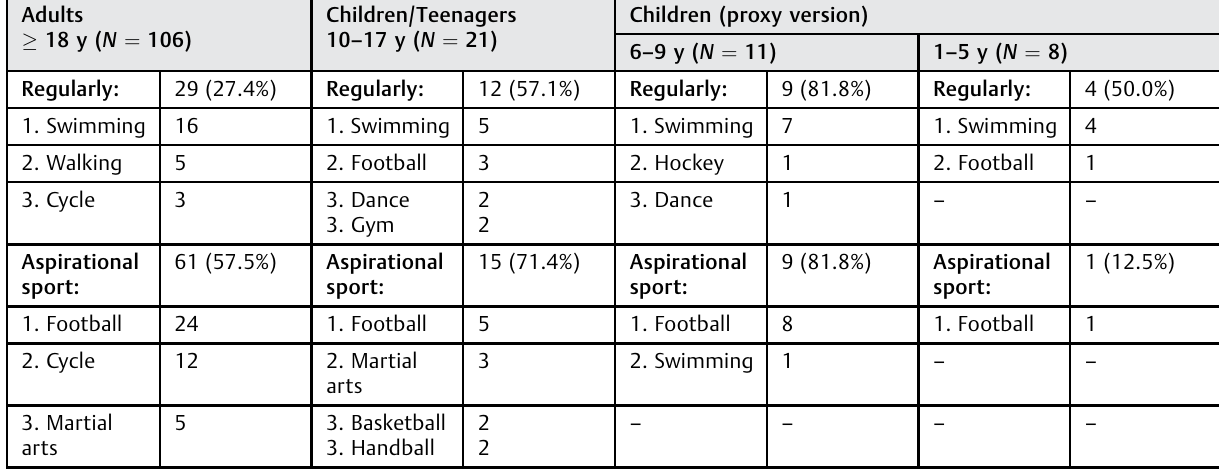
Table 4 Physical activity practice and aspirational sports of survey respondents Adults (cid:1) 18 y ( N ¼